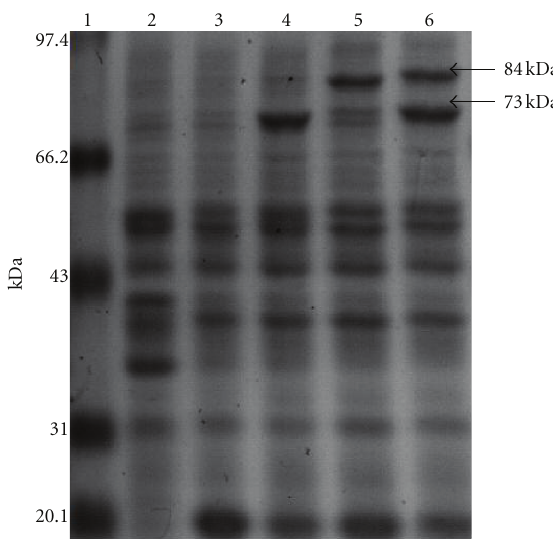
Figure 1: SDS-PAGE analysis of expressed proteins; 13% SDS- PAGE gel demonstrates the induction of tktA and ppsA gene expressions by 0.1 mM IPTG at 37 ◦ C; lane 1, Marker; lane 2, TRTH0709; lane 3, TRTH0709/Pstv28; lane 4, TRTH1012; lane 5, TRTH1011; lane 6, TRTH1013.